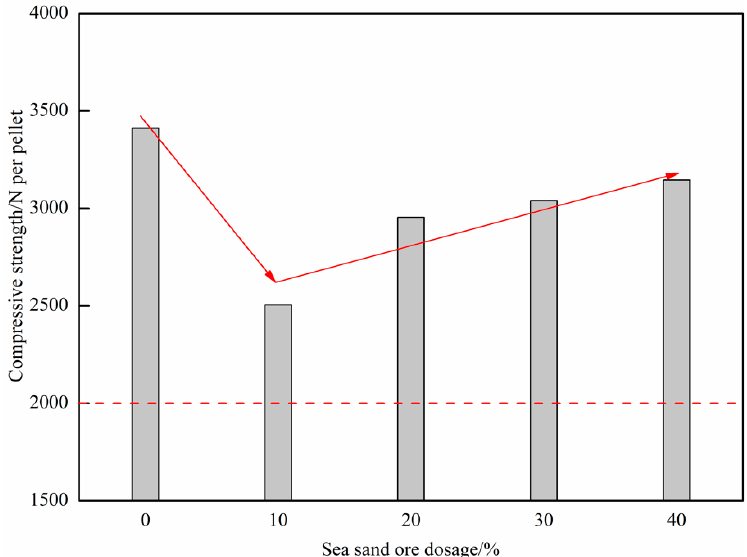
Figure 7. Compressive strength of oxidized pellets with different dosages of sea sand ore. XRD was used to analyze the oxidized pellets with 0%, 20%, and 40% sea sand ore added, and the results are shown in Figure 8. The oxidized pellets were mainly composed pellets, Fe was mainly present in Fe 2 O 3 and FeTiO 3 , and Ti was mainly present in FeTiO 3 . When sea sand ore increased to 40%, TiO 2 was formed. In addition, the silicate phase was mainly MgAl 2 Si 4 O 12 in oxidized pellets without sea sand ore; with increasing sea sand ore dosage, the silicate phase changed to Al 2 SiO 5 .